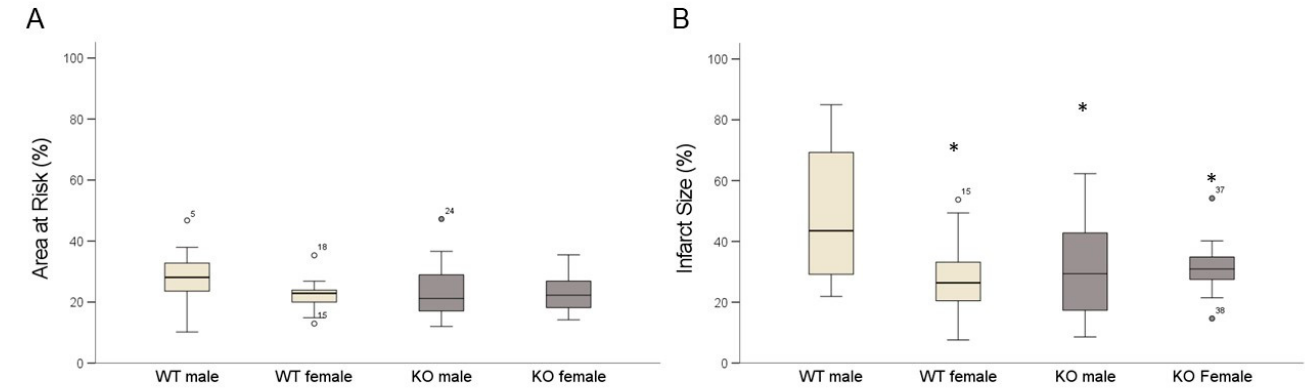
Figure 2. Male MAO-B KO mice benefit from MAO-B deletion regarding reduced size of infarcted area. ( A ) shows quantification of area at risk and ( B ) infarct size quantification. (WT male n = 14; WT female n = 9; KO male n = 11; KO female n = 11). Data are represented as box plots expressing median, 25% and 75% quartiles, upper and lower whisker and outliers. * p < 0.05 WT male vs. WT female, KO male, KO female, Student’s t -test.